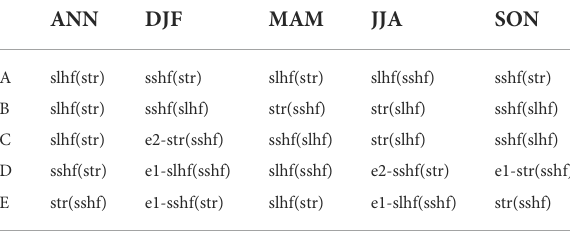
TABLE 3 Dominant energy of the whole year and four seasons in various